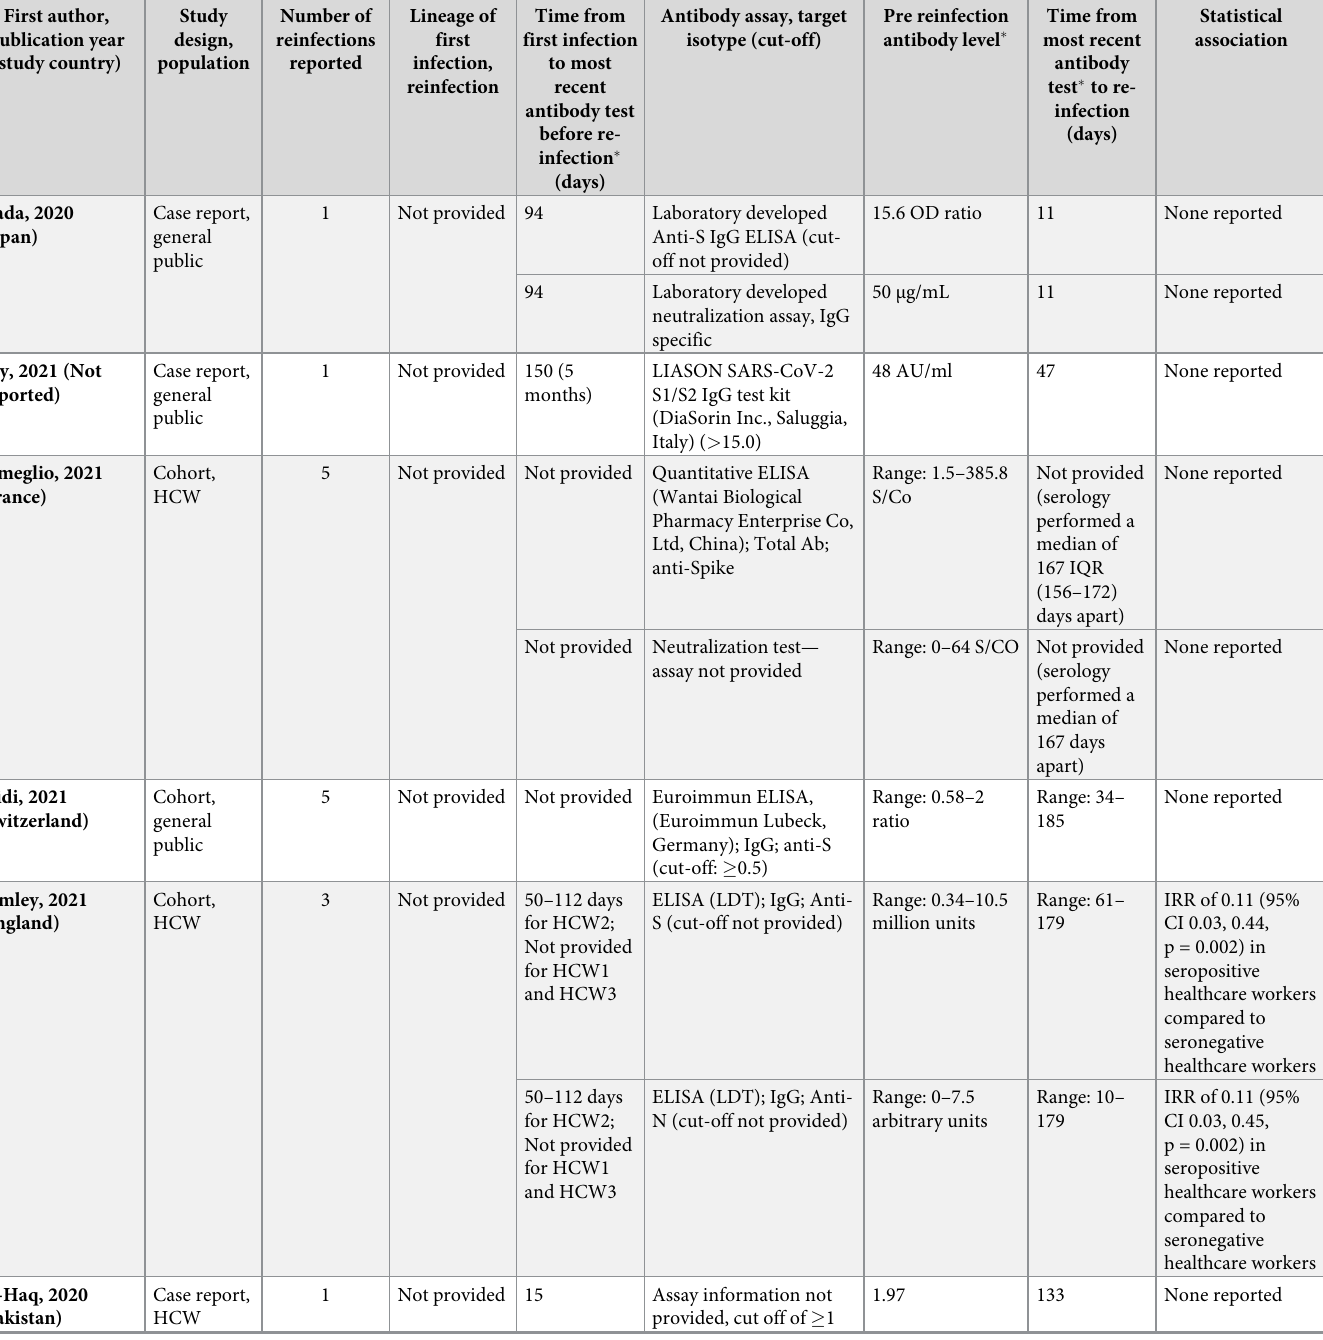
Table 3. Articles describing SARS-CoV-2 re-infection along with individual or aggregate humoral measures #